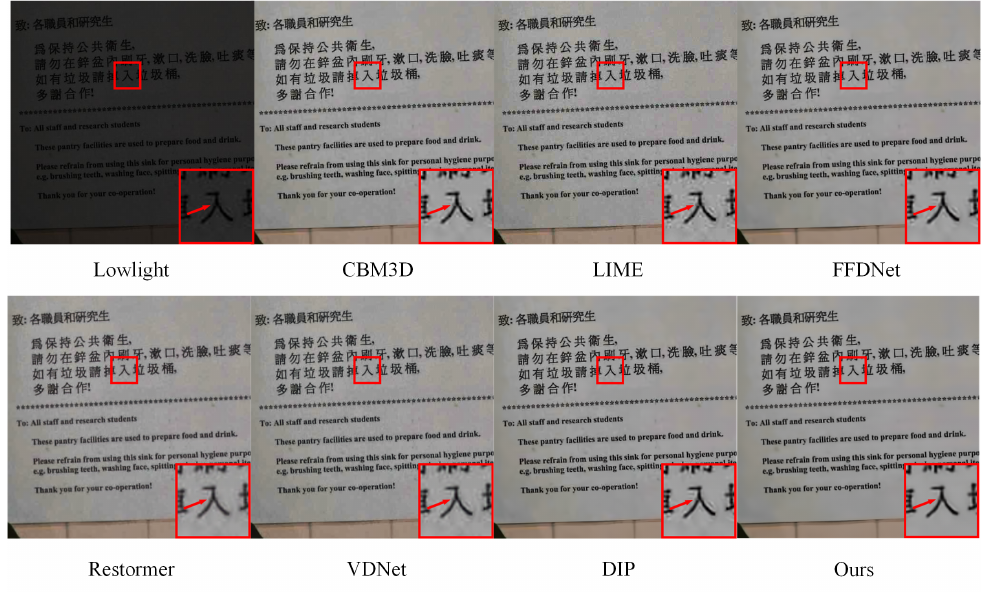
Figure 10. Visual comparison of the denoised images generated from different methods on the low-light